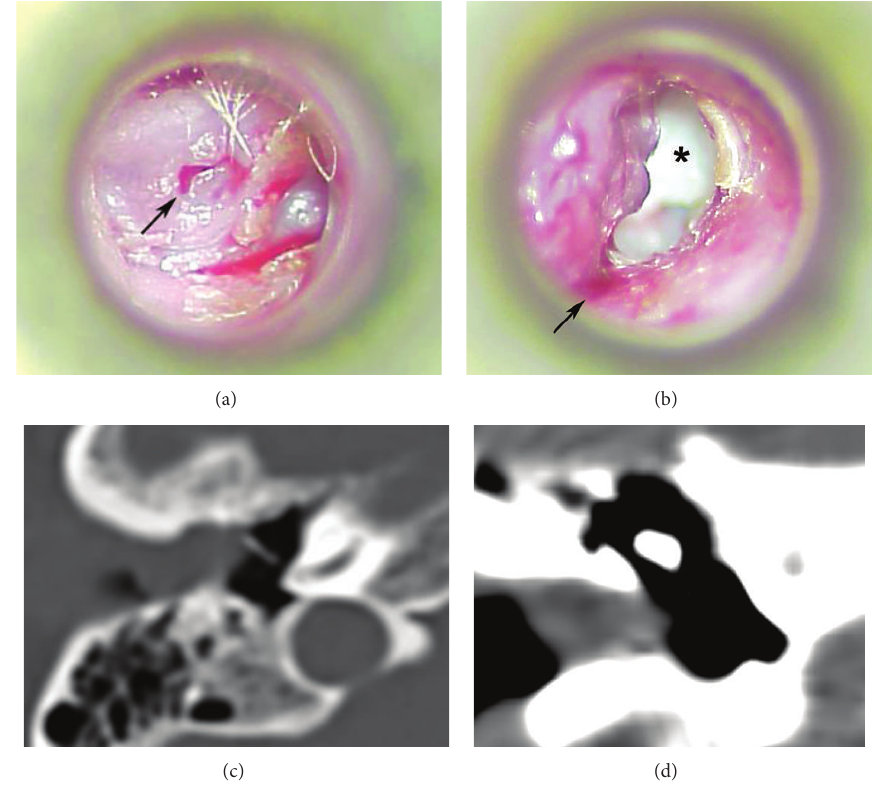
Figure 1: (a) Macroscopic appearance of the EAC polypoid mass with a hole in the center (arrow). (b) When the tumor was elevated, granular tissue was observed at the inferior wall of the EAC (arrow). A large plug of desquamated keratin was observed behind the lesion (asterisk). (c) The soft-tissue mass obstructing the slightly widened bony part of the EAC. (d) A soft-tissue window CT scan revealed the nonhomogenous structure of the